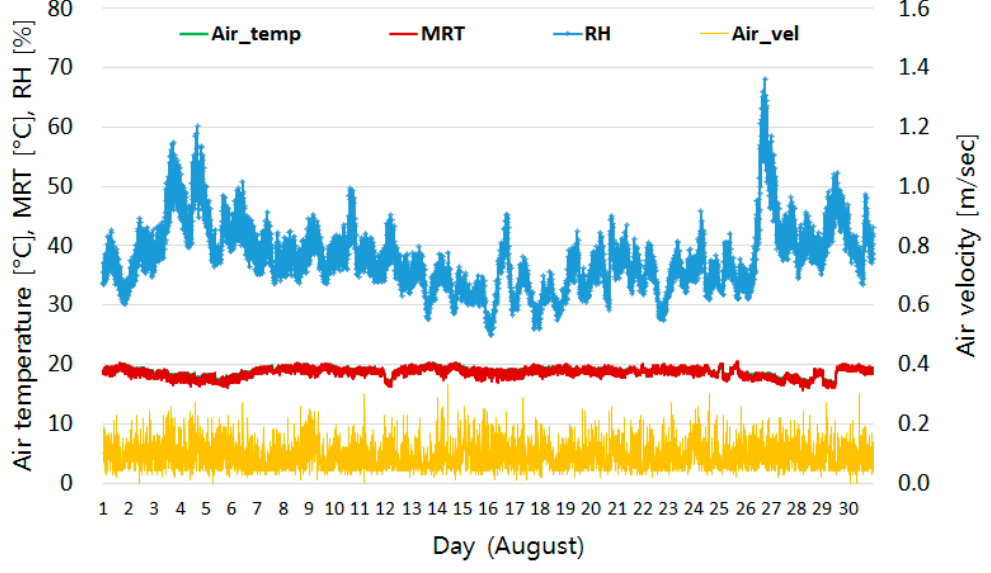
Figure 8. The data of four variables measured in the center of a cooling zone in August for demonstration of two scenarios.